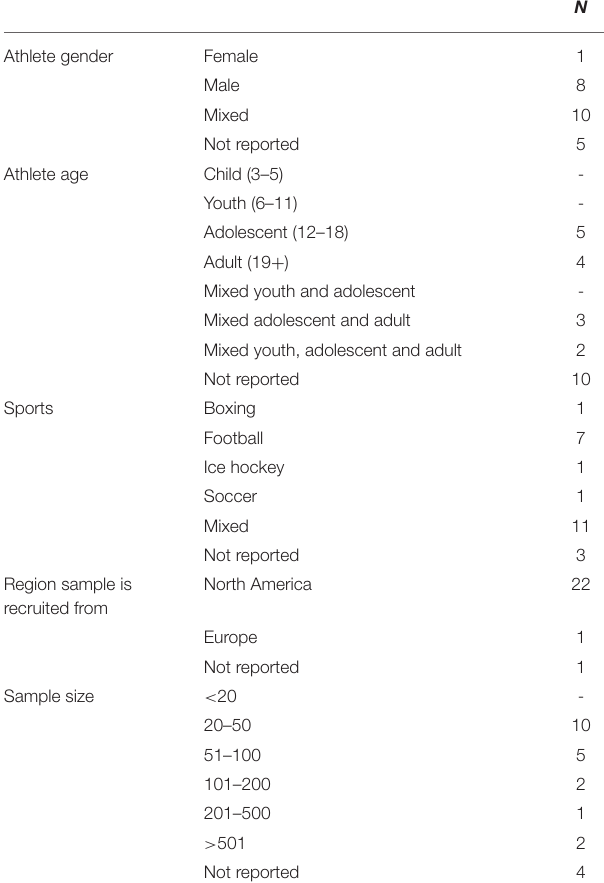
TABLE 2 | Study characteristics of the reviewed